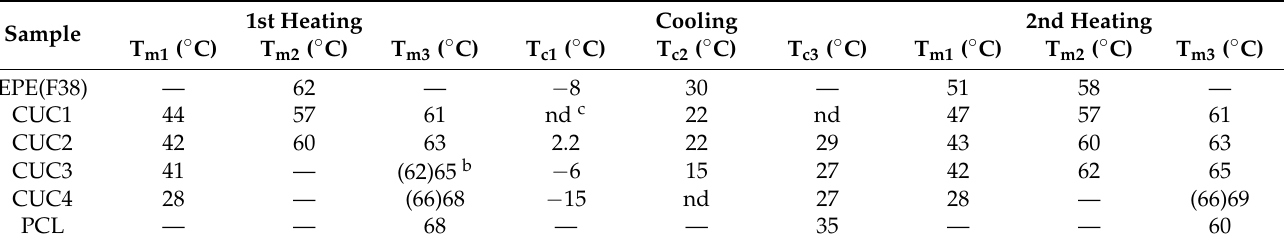
a T m and T c are melting and crystallization temperatures. the left side of the peak. c nd is not detected.